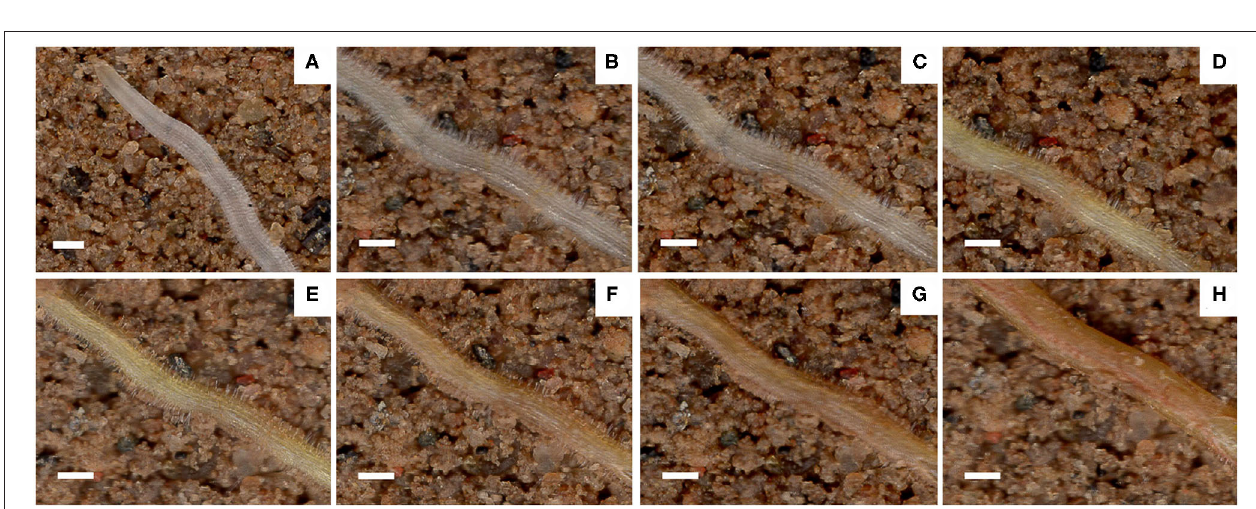
FIGURE 7 | Effect of phosphorus stress on the average root hair length (A) and root hair life span (B) after 50 days of phosphorus treatment. ND-PR, “Nongdamian No. 10” cultivar under replete phosphorus conditions; ND-PD, “Nongdamian No. 10” cultivar under low phosphorus; JM-PR, “Jimian 315” cultivar under replete phosphorus conditions; JM-PD, “Jimian 315” cultivar under low phosphorus; n , the number of root hair used to draw the curve. The P -values indicate the statistical significance of phosphorus stress on the median life span (days) of cotton plants.